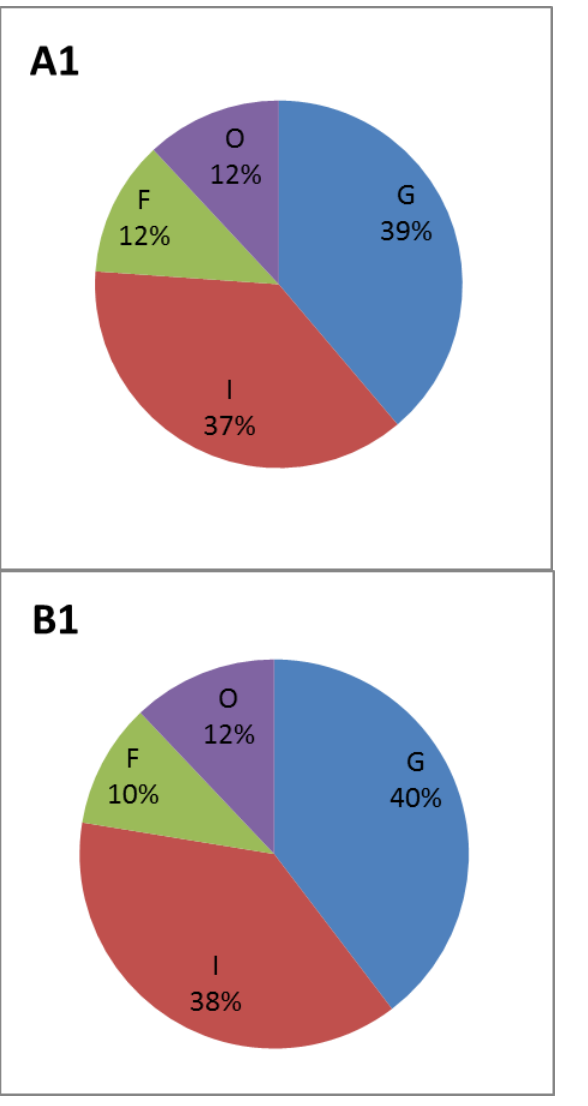
Fig 2. Proportions of main feeding guilds of avian assemblages in A) lowland, and B) foothill farmlands of Lesotho. 1 – based on the number of species (N = 67 in lowlands, N = 58 in foothills); 2 – based on the number of resident pairs (N = 672 in lowlands, N = 523 in foothills); G – granivores, I – insectivores, F – frugivores, O –